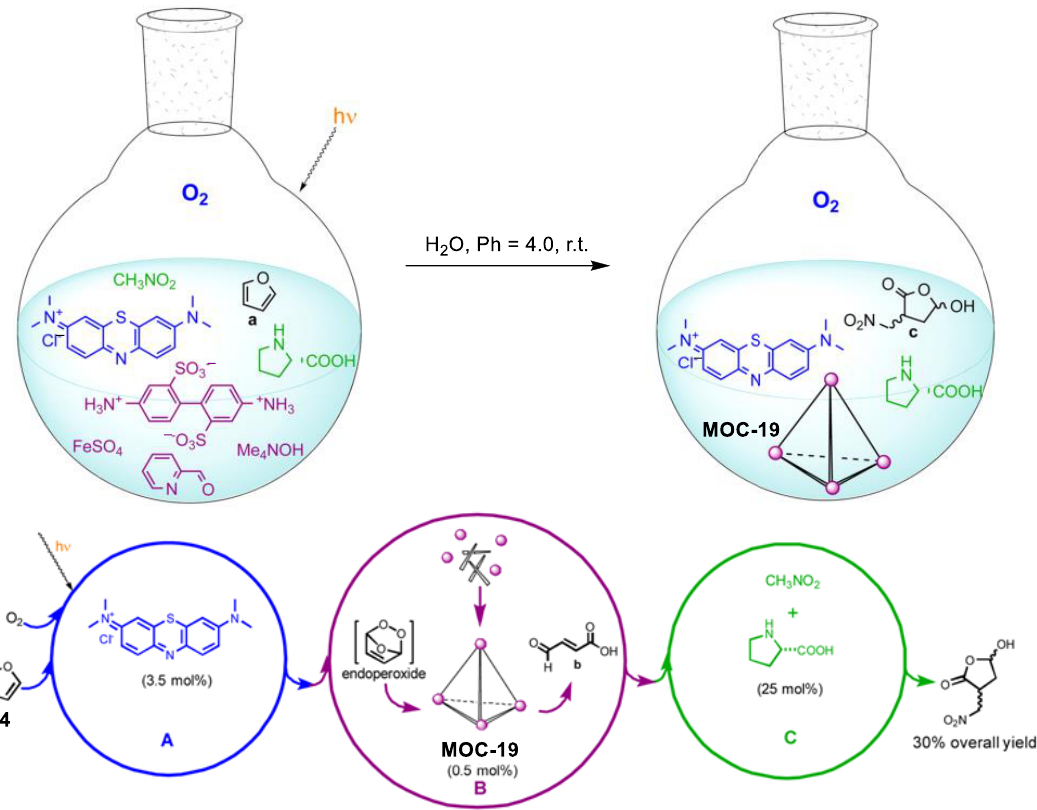
Figure 19. One-pot sequential transformation from into a chiral hydroxylactone catalyzed by singlet oxygen (photogenerated by methylene blue), in situ assembled metal − organic cage MOC-19 , and L-proline [92]. Reaction conditions: 24 (2.6 mmol), MOC-19 (0.5 mol%), methylene blue (3.5 mol%), L-proline (25 mol%) H 2 O, r.t., O 2 atmosphere . Reprinted/adapted with permission from Ref. [92]. Copyright 2013 American Chemical Society.